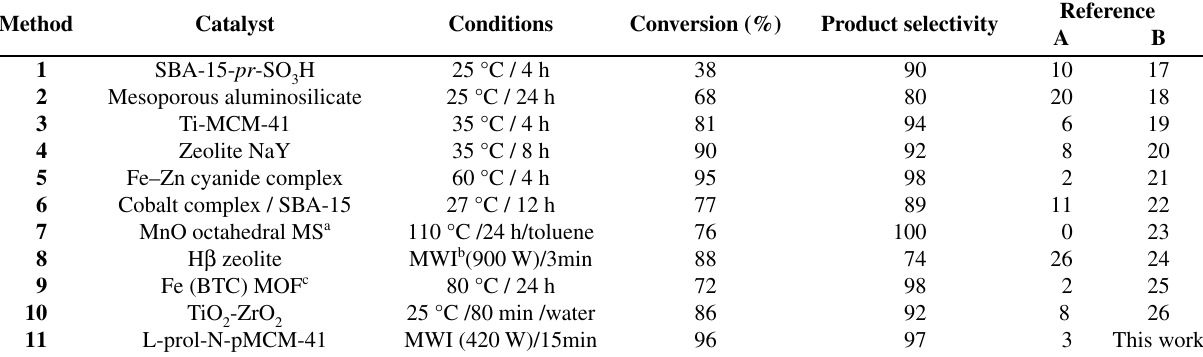
Table 4. Literature results for the ring opening of styrene oxide with aniline under various heterogeneous conditions. Method